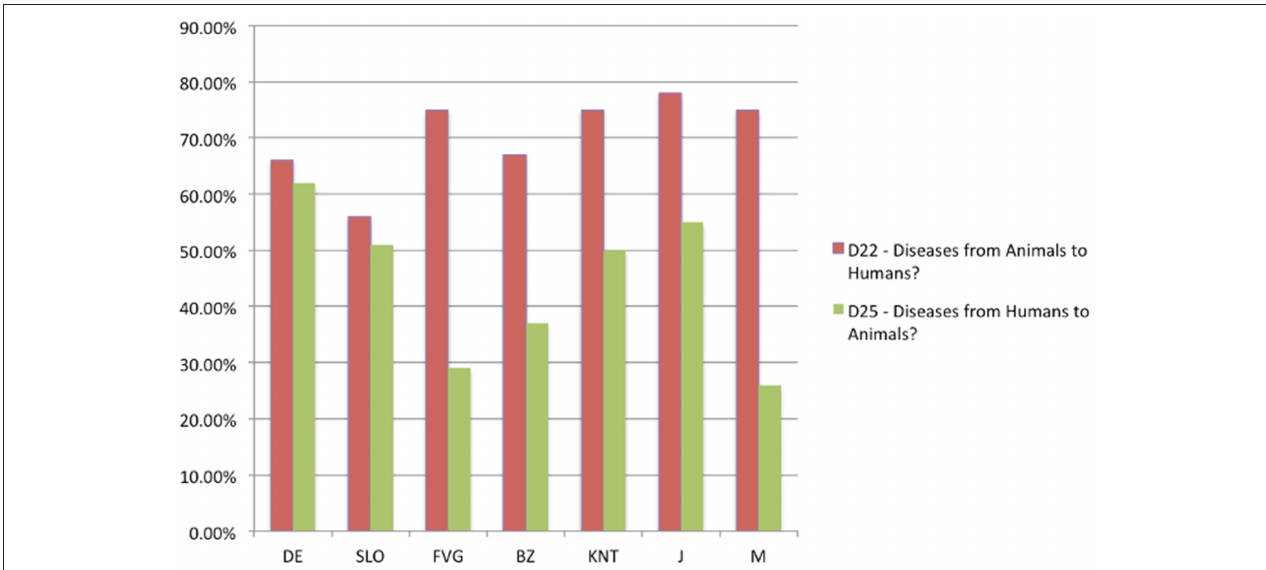
FIGURE 13 | Q22 and Q25: “Many diseases that affect humans come from animals?”–“Can humans transmit diseases to animals?” [Axes X regions or countries, Axes Y % correct answers–DE, Germany; SLO, Slovenia; FVG, Friuli Venezia Giulia Italy; BZ, Autonomous Province of Bolzano Italy; KNT, Carinthia Austria; J, Japan; M, Mauritius–( n =